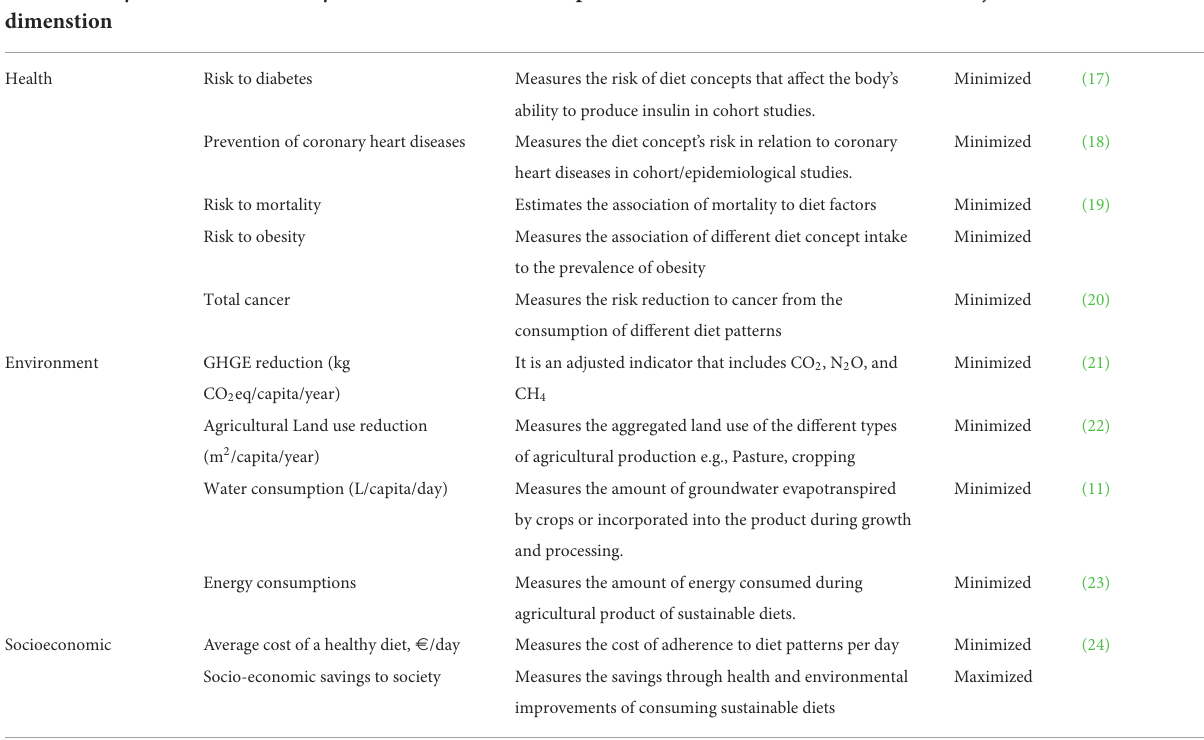
TABLE 1 Metrics for evaluating sustainable diet concepts.